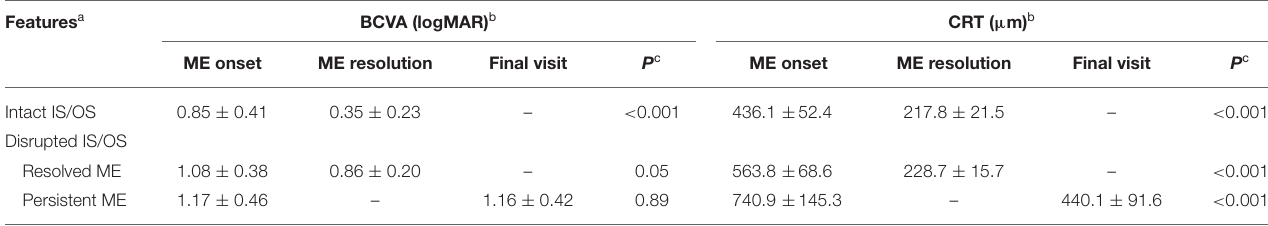
TABLE 3 | Mean CRT and BCVA (in logMAR units) at various timepoints. Features a